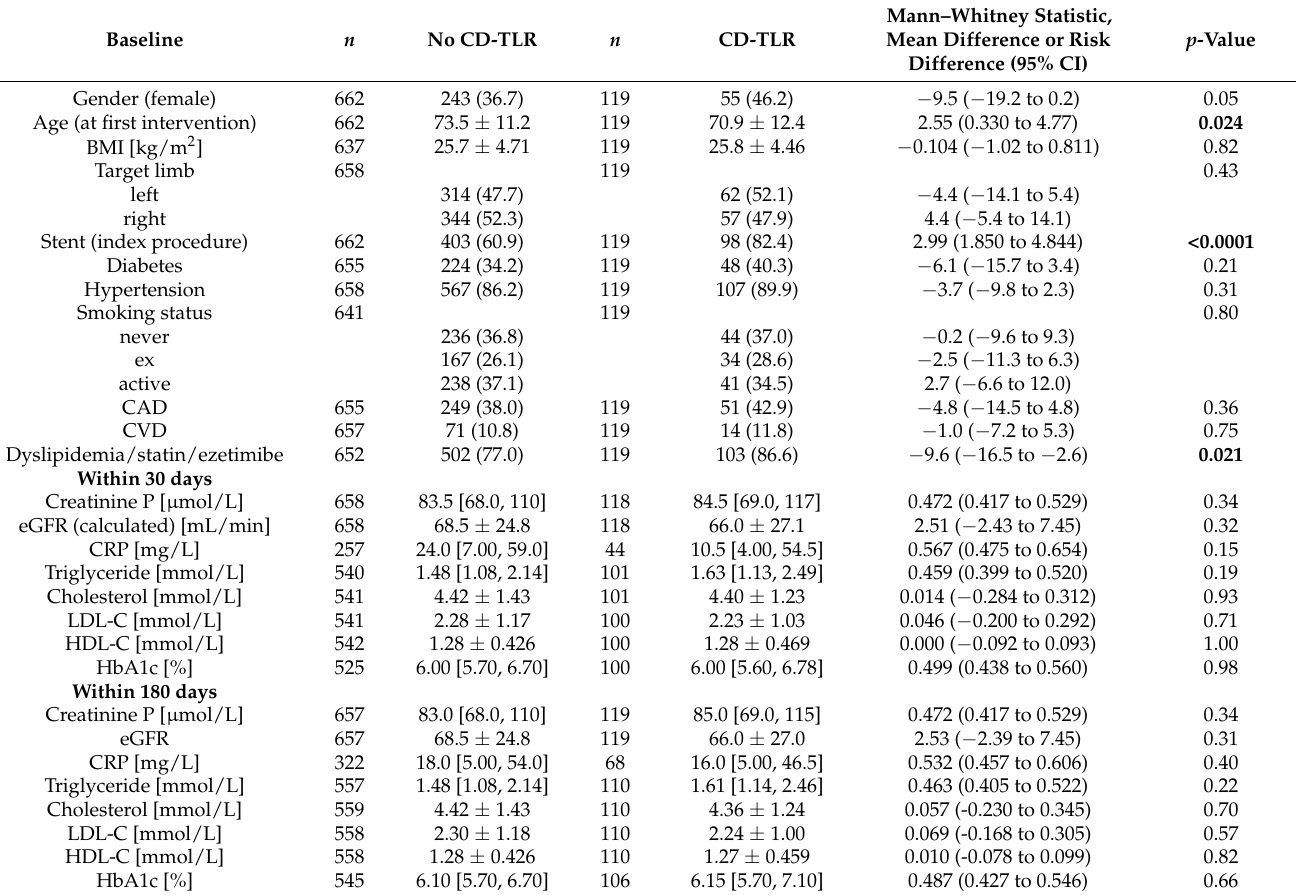
Table 2. Baseline characteristics including risk factors, and laboratory values up to 30 or 180 days after the primary intervention for both groups (no CD-TLR vs. CD-TLR).